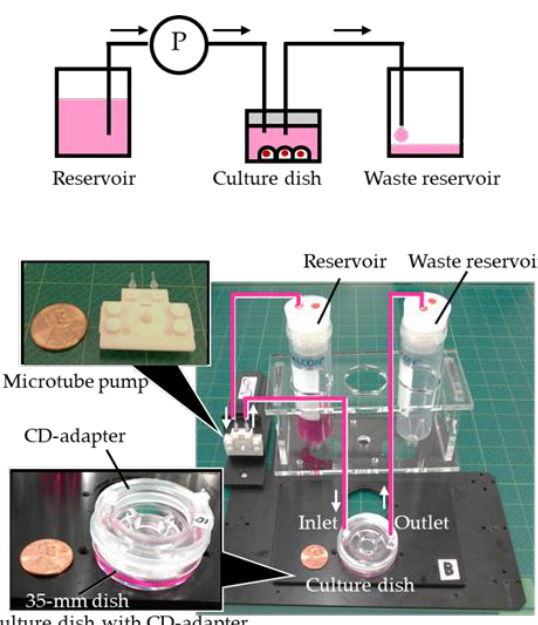
Figure 5. Schematic of the culturing system and photo of the experimental setup. A CD-adapter was attached to a 35-mm culture dish on which cells had been seeded, and connected to a micro tube pump system, reservoir, and waste reservoir. The size of the experimental setup is 200 × 150 × 150 mm, which can be installed on a stage of the microscope and also can be installed in the incubator.